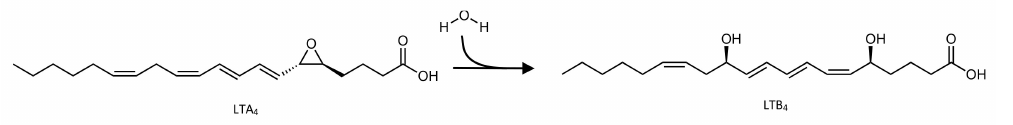
Figure 9. Schematic representation of the reaction catalyzed by the epoxide hydrolase activity of the LTA 4 H enzyme.